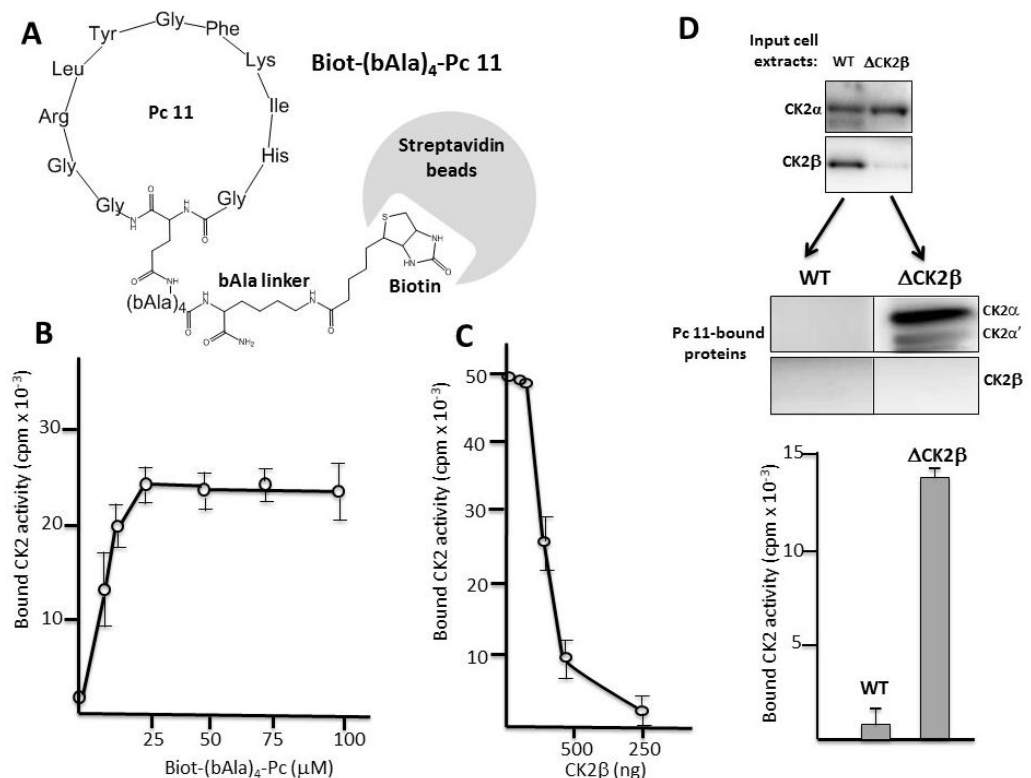
Figure 3. Pc binds to CK2α. ( A ) Biot-(bAla) 4 -Pc: Head-to-tail cyclic Pc 11 analogue linked to biotin through a 4-Ala linker; ( B ) aliquots of streptavidin-agarose beads were incubated with increasing concentrations of Biot-(bAla) 4 -Pc 11 in the presence of CK2α (100 ng) for 2 h at 4 °C. After three washes, CK2 activity assays were carried out for 5 min on the beads pellets. Representative data shown from two independent experiments. Results are presented as mean ± s.d. of triplicates; ( C ) aliquots of streptavidin-agarose beads were loaded with 25 µM Biot-(bAla) 4 -Pc 11 and incubated with CK2α (100 ng) in the presence of increasing amounts of CK2β for 2 h at 4 °C. After three washes, CK2 activity assays were carried out for 10 min on the beads pellets; ( D ) Pc binds to CK2α in cell extracts. Aliquots of streptavidin-agarose beads loaded with 25 µM Biot-(bAla) 4 -Pc 11 were incubated with WT or CK2β-depleted MCF-10A cell extracts (upper panel) for 2 h at 4 °C. After three washes, CK2 subunits retained on the beads were determined by Western blot (middle panel). CK2 activity was also determined in the bead pellets with the CK2β-independent peptide substrate (lower panel).